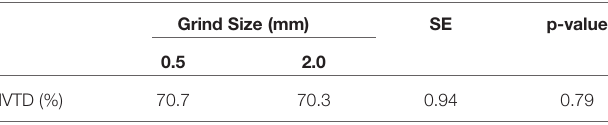
TABLE 2 | Effect of grind size on in vitro true digestibility a (IVTD) of in fl orescence from nine non-extracted industrial hemp cultivars b